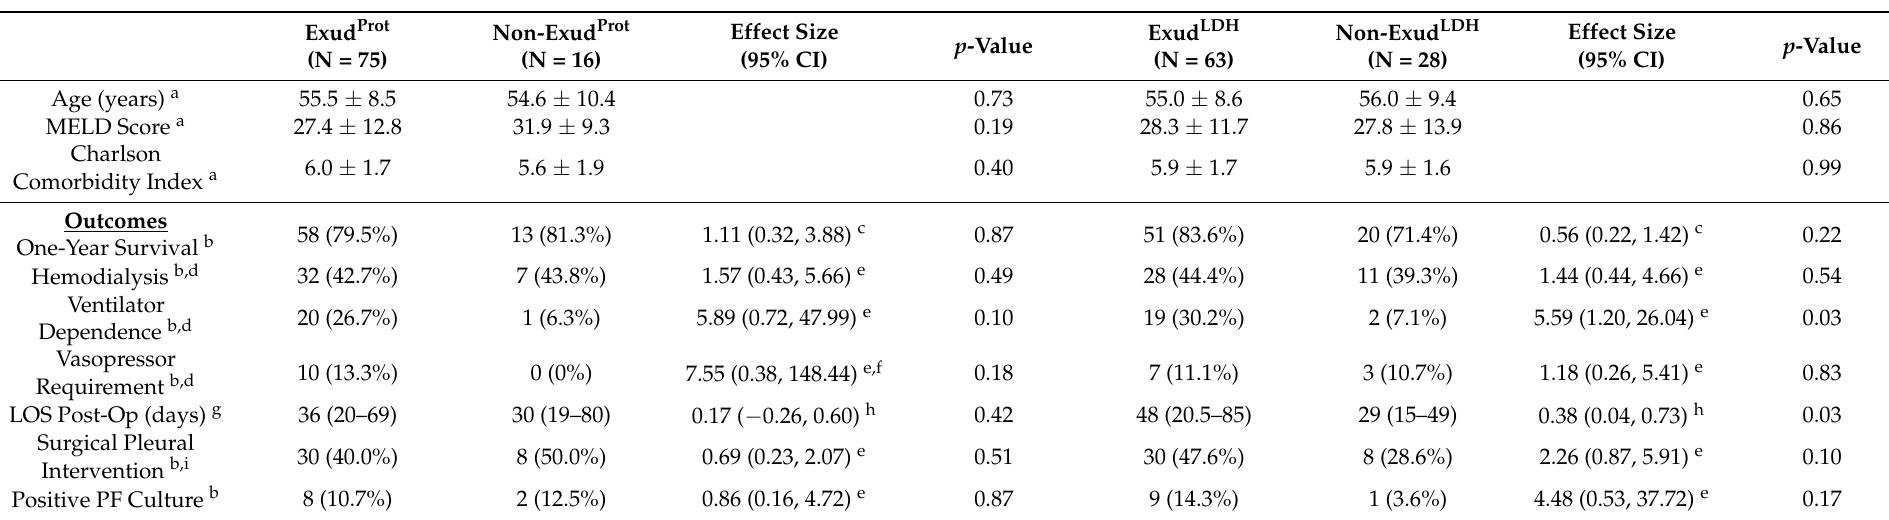
Table 3. Outcomes for exudates with elevated lactate dehydrogenase (Exud LDH ) or with elevated protein (Exud Prot ) vs.